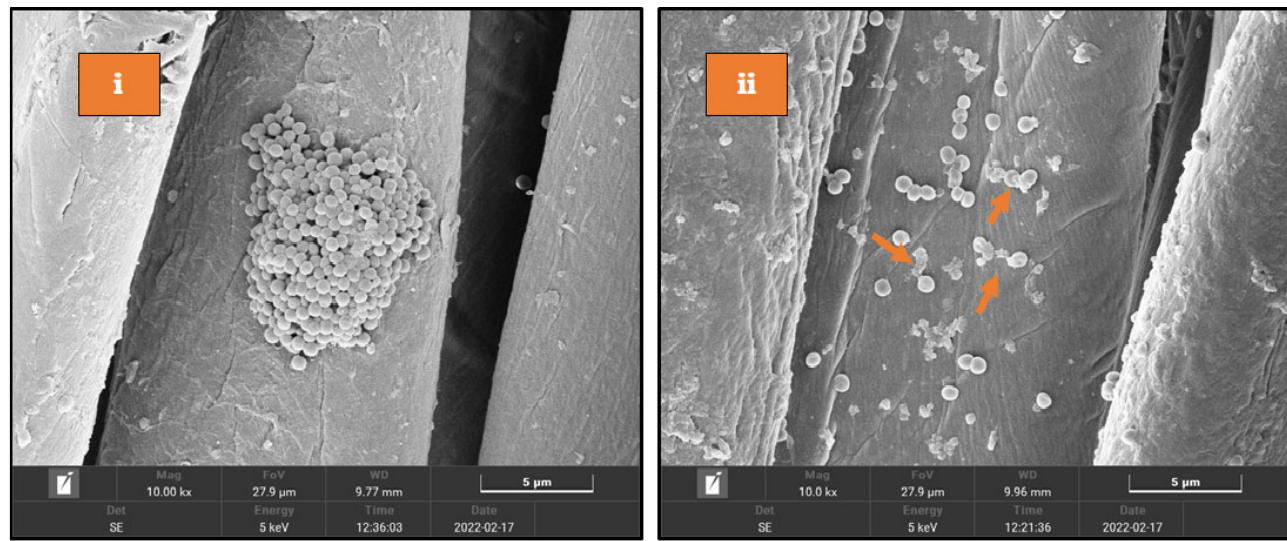
Figure 10. SEM images of S. aureus cells incubated on the fabric samples for 48 h; ( i ) Uncoated fabric ( ii ) Se-coated-30. The scale bar was 5 μ m.